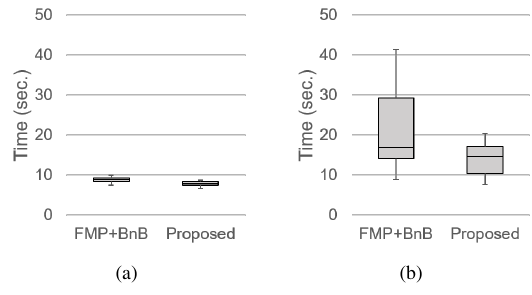
Figure 8. Computation-time comparison between FMP+BnB and proposed method (a) for regular pairs in Trees dataset, and (b) for irregular pairs in Trees dataset Figure 6. Computation-time comparison between FMP+BnB Table 5 shows the computation-time ratios. The proposed and proposed method (a) for regular pairs in Arch dataset, (b) method was more efficient than FMP+BnB for all pairs except irregular pairs in Arch dataset s1-s2 . The harmonic mean of all ratios was 0 . 68